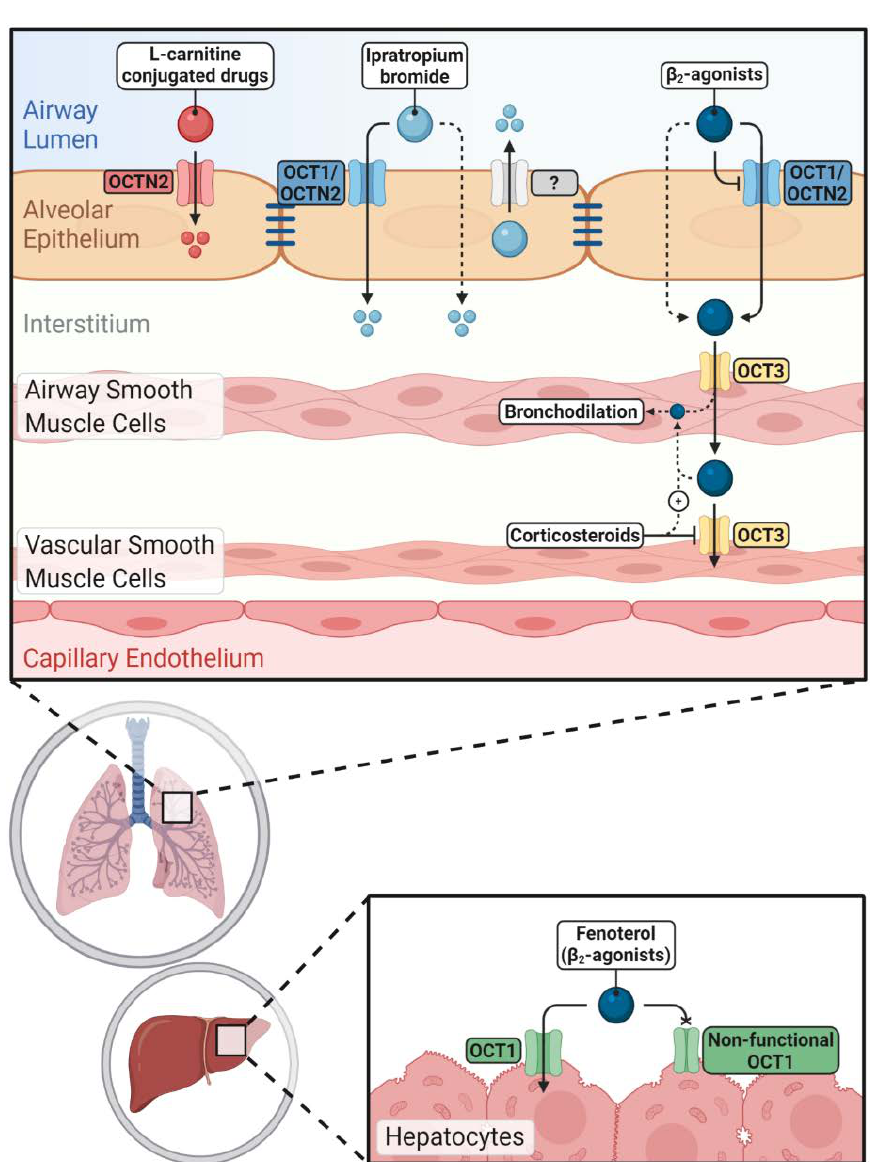
Figure 2. Impacts of novel/organic cation transporters (OCT/Ns) on pulmonary and systemic disposition of inhaled drugs. Inhaled cationic β 2 -agonists’ epithelial transport is mediated either by OCT/Ns (mainly OCT1 and OCTN2) or passive diffusion. Corticosteroids can increase the airway retention of β 2 -agonists by inhibiting OCT3 in vascular smooth muscle cells. Hepatic clearance of fenoterol is reduced in carriers of non-functional OCT1 alleles. Ipratropium bromide uptake via airway epithelium is more complex and OCT/Ns, unidentified efflux transporters and passive diffusion are participating. OCTN2 mediates the uptake of L -carnitine-conjugated prodrugs and nanoparticles into pulmonary epithelial cells improving pulmonary delivery of the parent drugs.